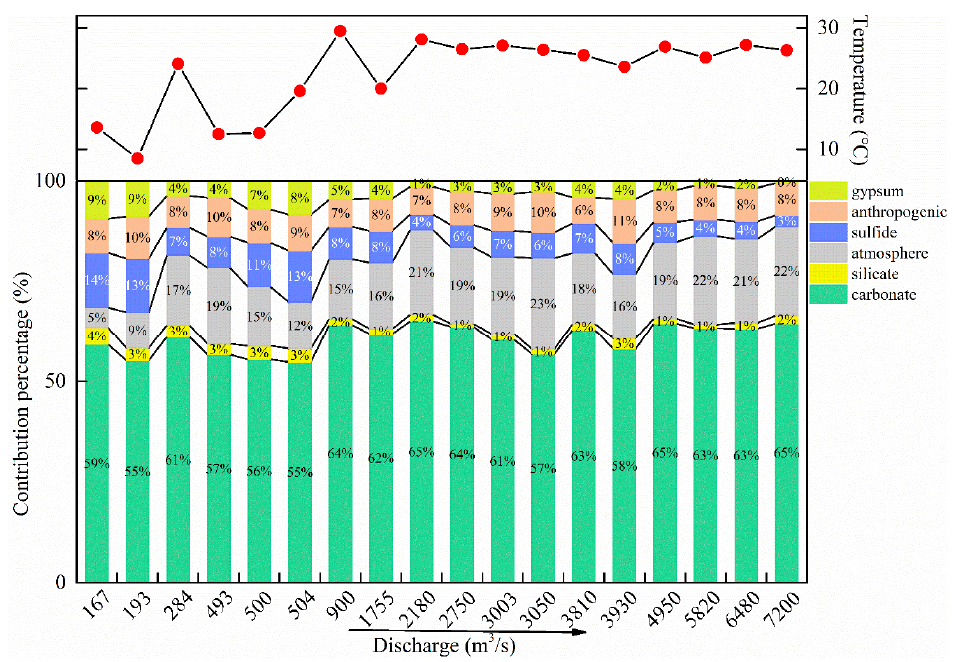
Figure 7. The contribution percentage of different end-members under various temperature and discharge conditions for the Liujiang River in a hydrological year. discharge conditions for the Liujiang River in a hydrological